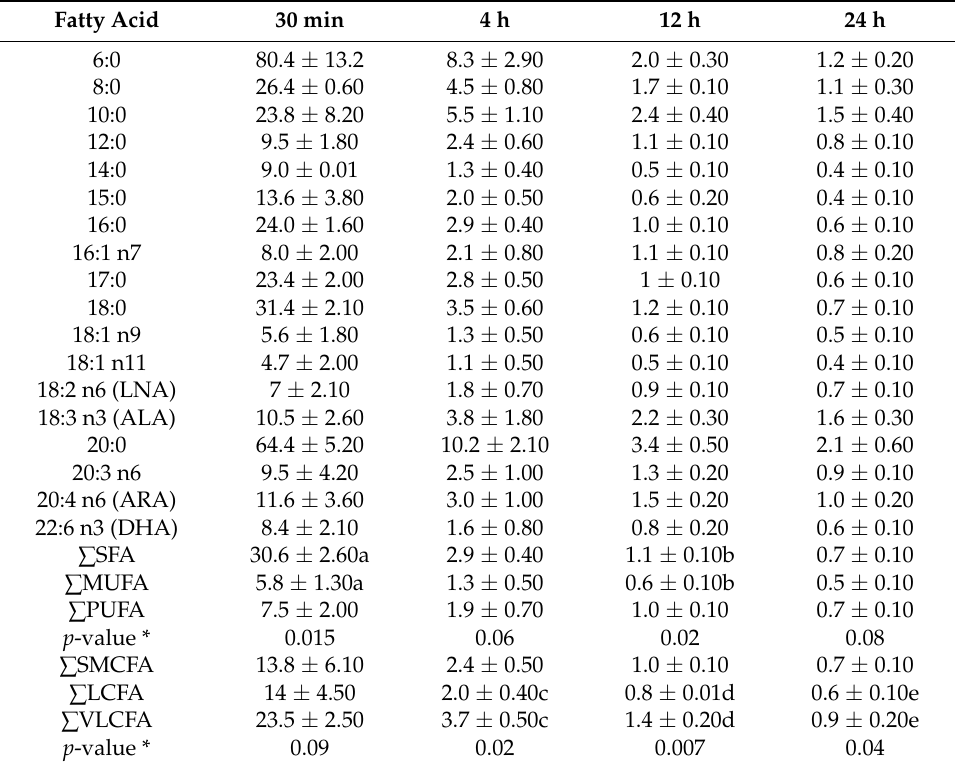
Table 2. Percentage of fatty acid loss (% of the total amount of FA initially infused that was recovered from the tube after the infusion